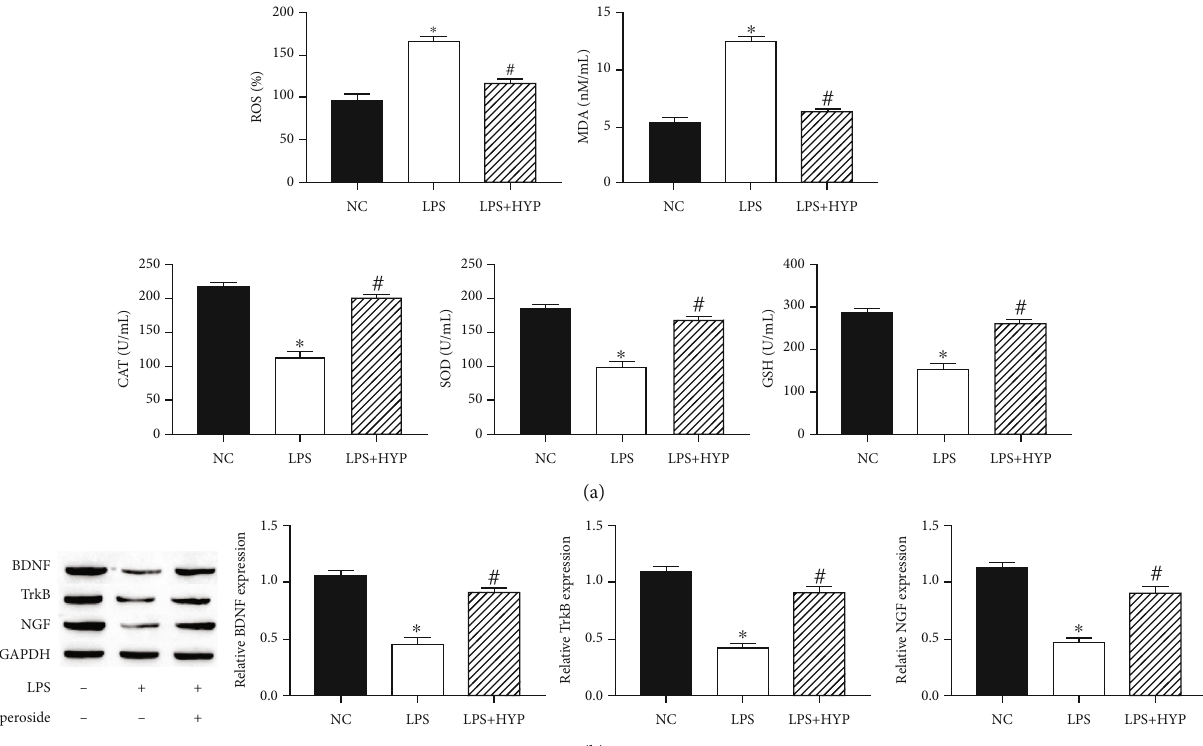
Figure 2: Hyperoside alleviated oxidative stress and reduction of neurotrophic factor in the LPS-induced HT22 cells. The levels of SOD, GSH, CAT, ROS, and MDA were measured by corresponding assay kits (a). The expression of BDNF, TrkB, and NGF in HT22 cells was measured by western blotting (b). ∗ was considered signi fi cant compared to control ( ∗ P < 0 : 05 ); # was considered signi fi cant compared to LPS ( # P < 0 : 05